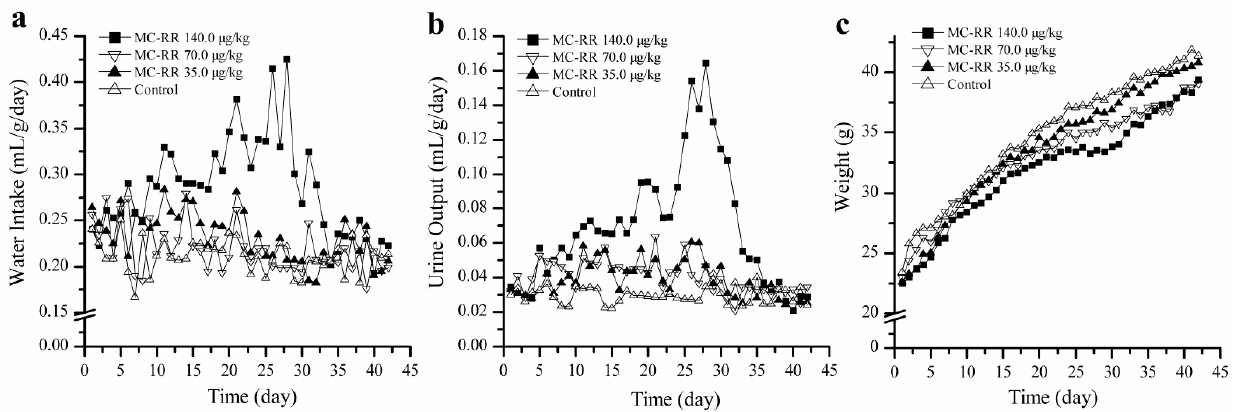
Figure 4. Water intake ( a ), urine output ( b ) and body weight ( c ) of mice treated with MC-RR in the continuous exposure experiment.